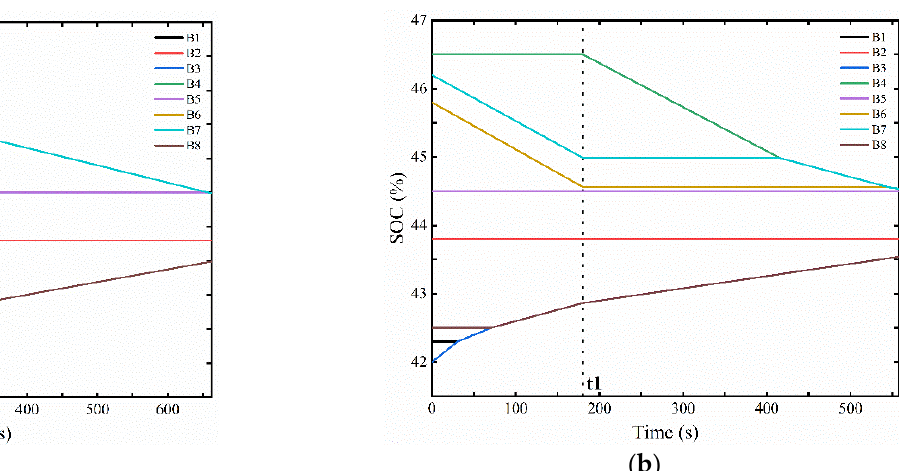
Figure 18. ( a ) AC2AC equalization simulation results ( b ) MC2AC equalization simulation results. Table 3. Equalization results for AC2AC and MC2AC control strategies.